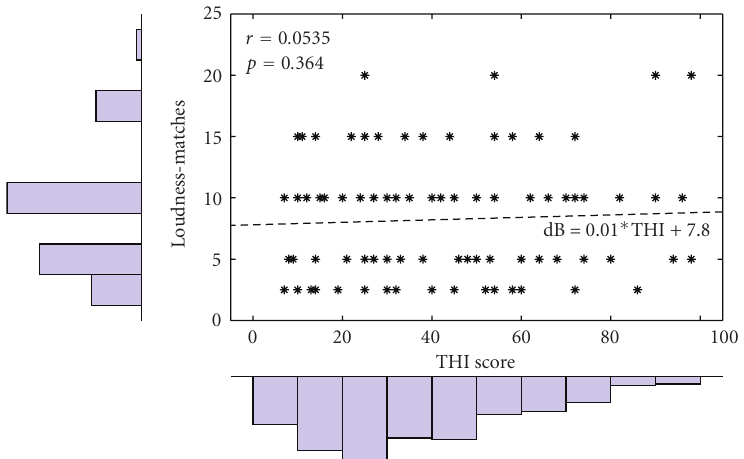
Figure 4: Regression analysis of THI and loudness